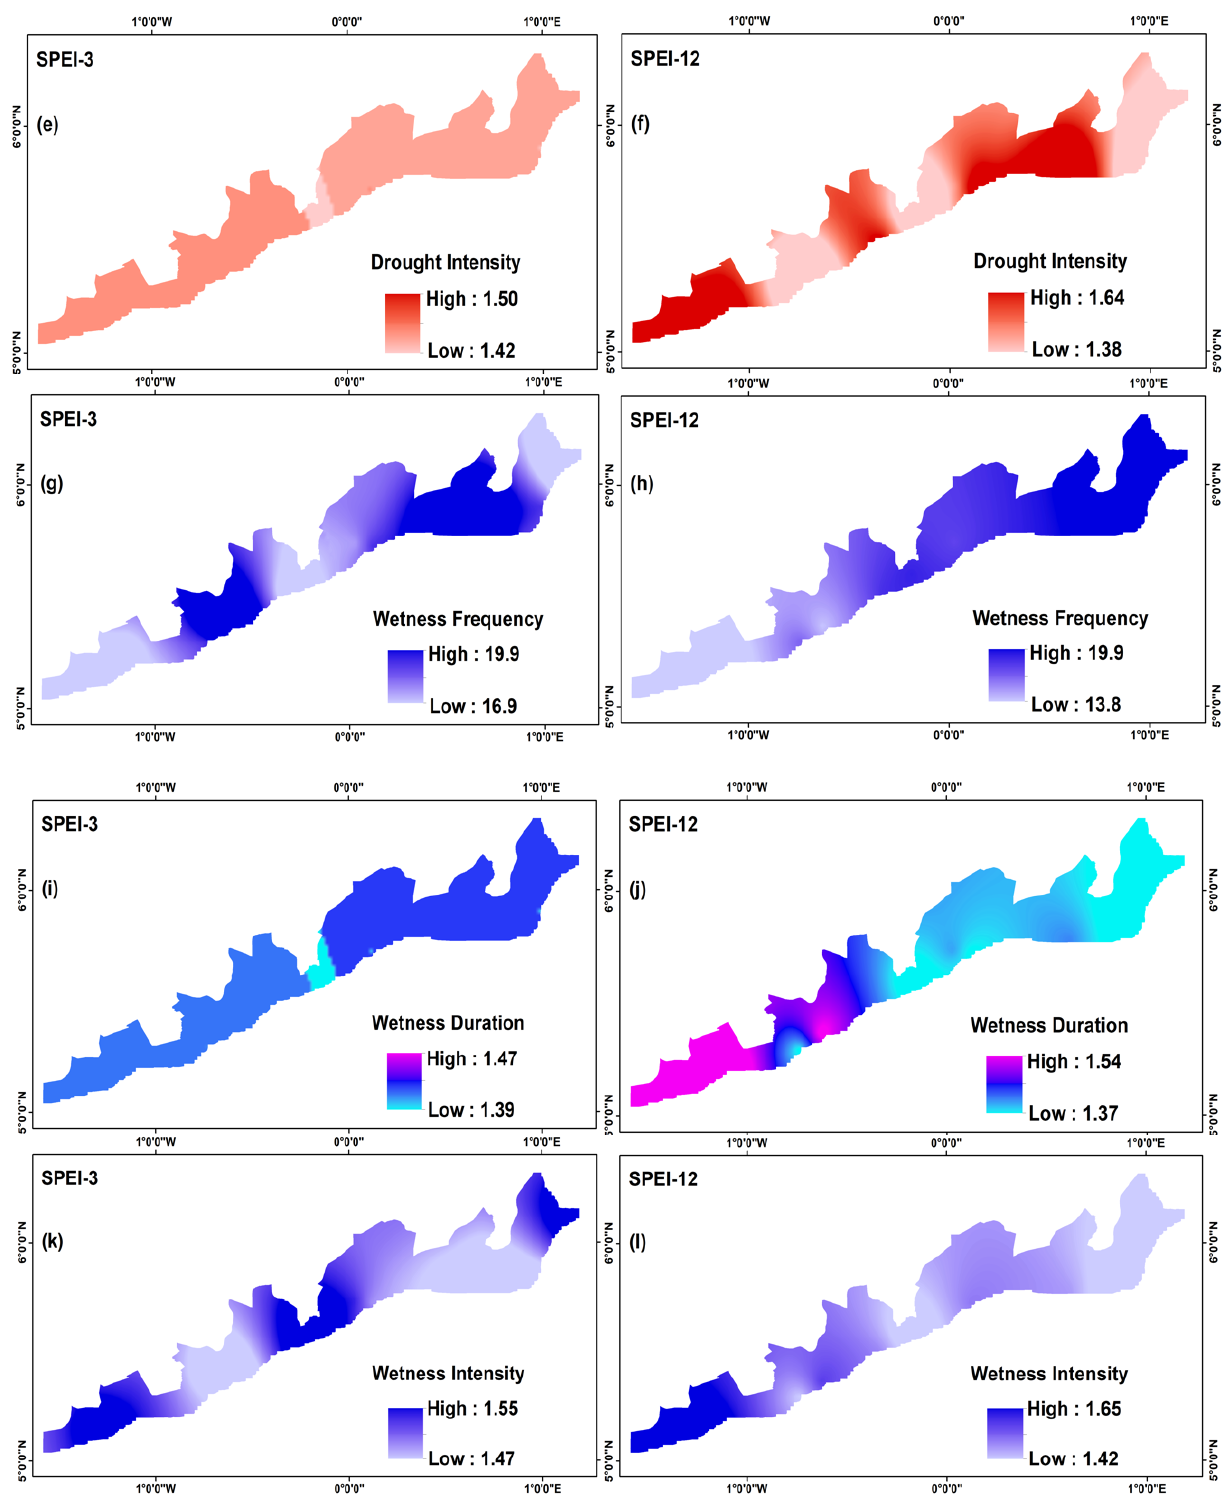
Figure 6. Spatial distribution of drought and wetness characteristics at SPEI-3 and SPEI-12 timescales in the coastal Savannah agroecological of Ghana from 1981–2021: Drought frequency ( a , b ) SPEI-3 and SPEI-12; drought duration ( c , d ) SPEI-3 and SPEI-12; drought intensity ( e , f ) SPEI-3 and SPEI-12; wetness frequency ( g , h ) SPEI-3 and SPEI-12; wetness duration ( i , j ) SPEI-3 and SPEI-12; wetness intensity ( k , l ) SPEI-3 and SPEI-12.